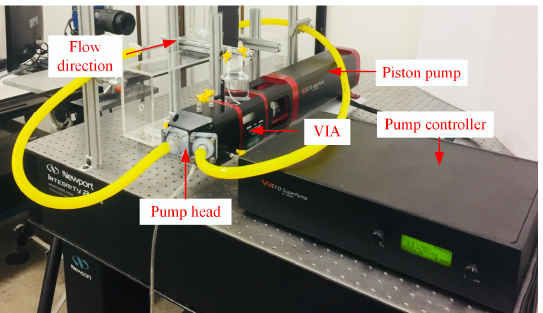
Figure 2. Two-dimensional PIV system setup for the aneurysm flow